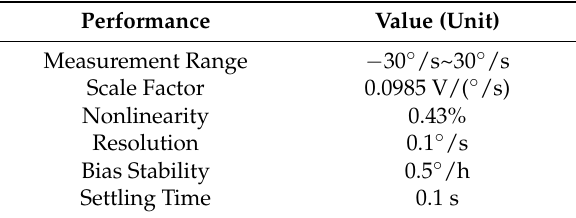
Table 1. Performance of the fabricated gyroscope.